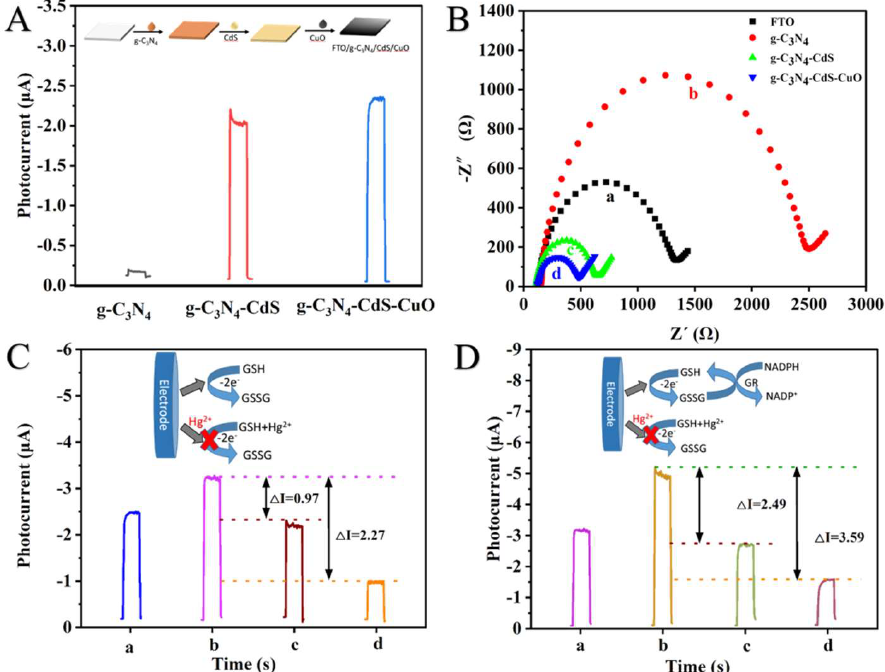
Figure 3. PEC responses of the FTO electrode in PBS buffer solutions containing: g-C 3 N 4 /FTO; CdS-g-C 3 N 4 /FTO; CuO-CdS-g-C 3 N 4 /FTO ( A ); and EIS of the electrode, a, bare FTO; b, g-C 3 N 4 /FTO; c, CdS-g-C 3 N 4 /FTO; d, CuO-CdS-g-C 3 N 4 /FTO ( B ). The photocurrent response of a, CuO-CdS-g-